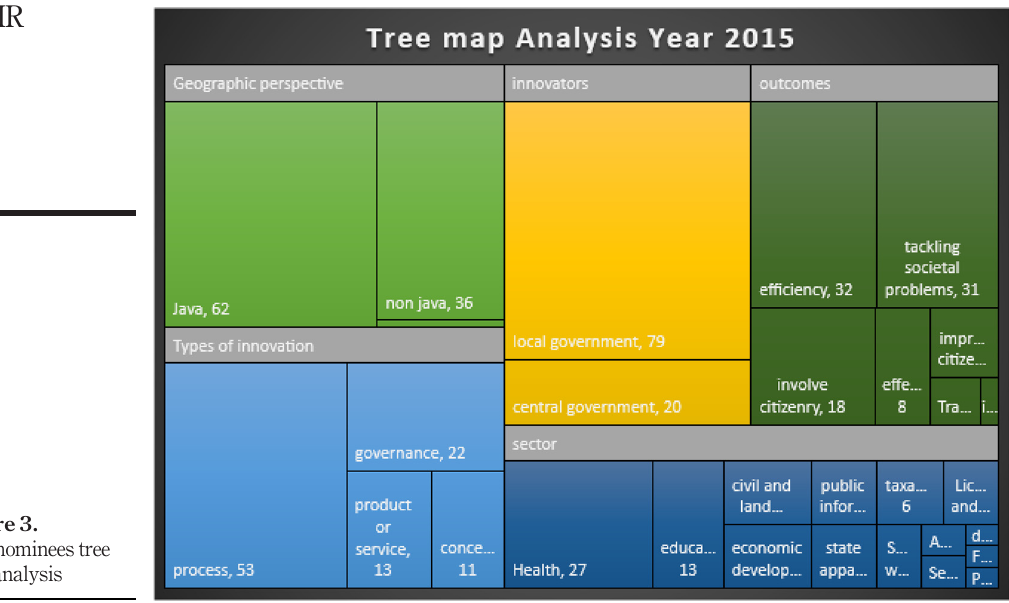
Figure 3. 2015 nominees tree map